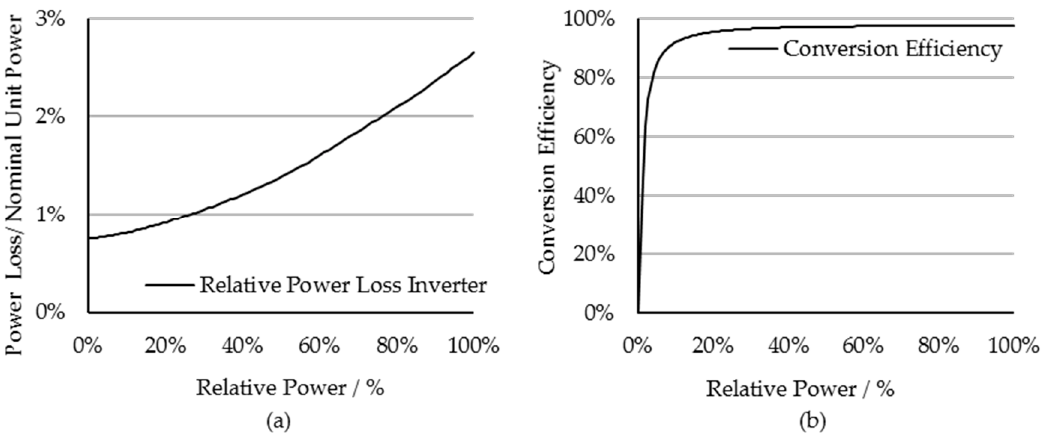
Figure 1. Power losses in a bidirectional inverter: ( a ) power losses over relative power; and ( b ) conversion energy efficiency over relative power. Data from [7].